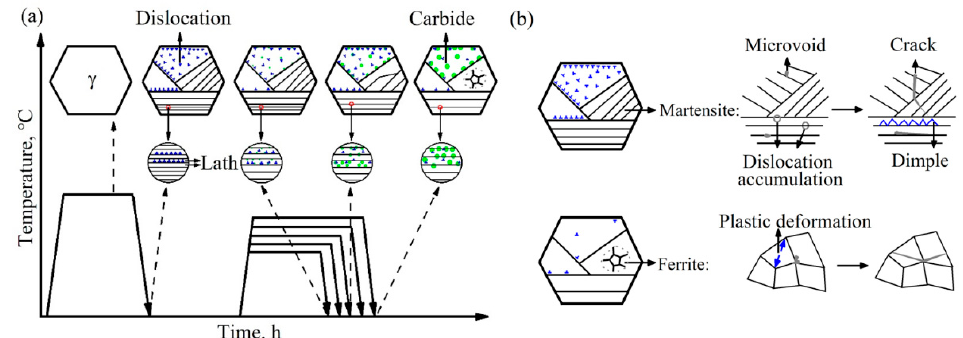
Figure 10. Schematic illustration of ( a ) microstructural evolution of the specimens after different heat treatments, ( b ) crack initiation and propagation of the specimens after impact test.